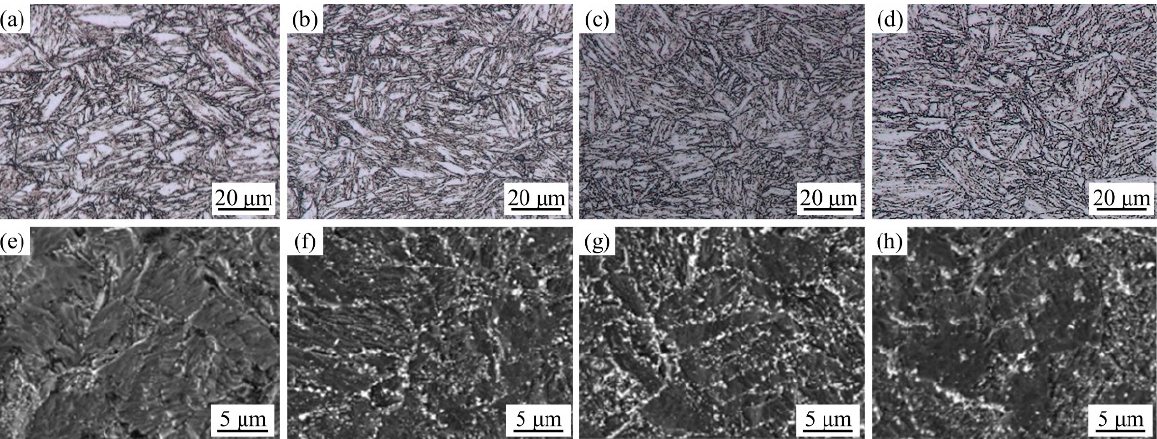
Figure 7. Microstructure morphology of 0.004Zr alloy treated by Process F, G, H and I. ( a – d ) OM, ( e – h ) SEM, ( a ) and ( e ) 0.004ZrF, ( b ) and ( f ) 0.004ZrG, ( c ) and ( g ) 0.004ZrH, ( d ) and ( h ) 0.004ZrI.